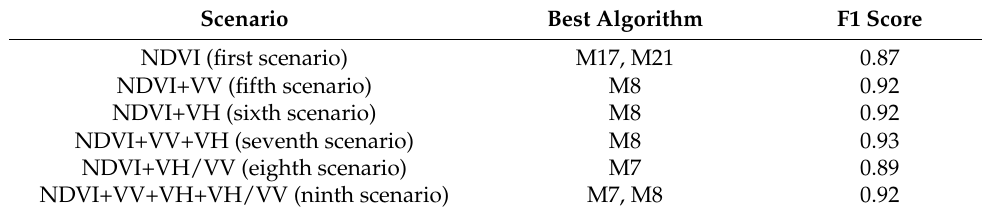
Table 5. Best performing algorithms in the second approach for each scenario and their F1 score. Scenario